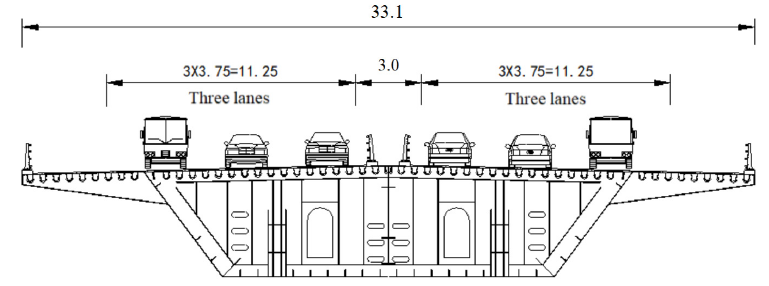
Figure 4. Layout diagram of cross-section of the girder in this study (unit: m).